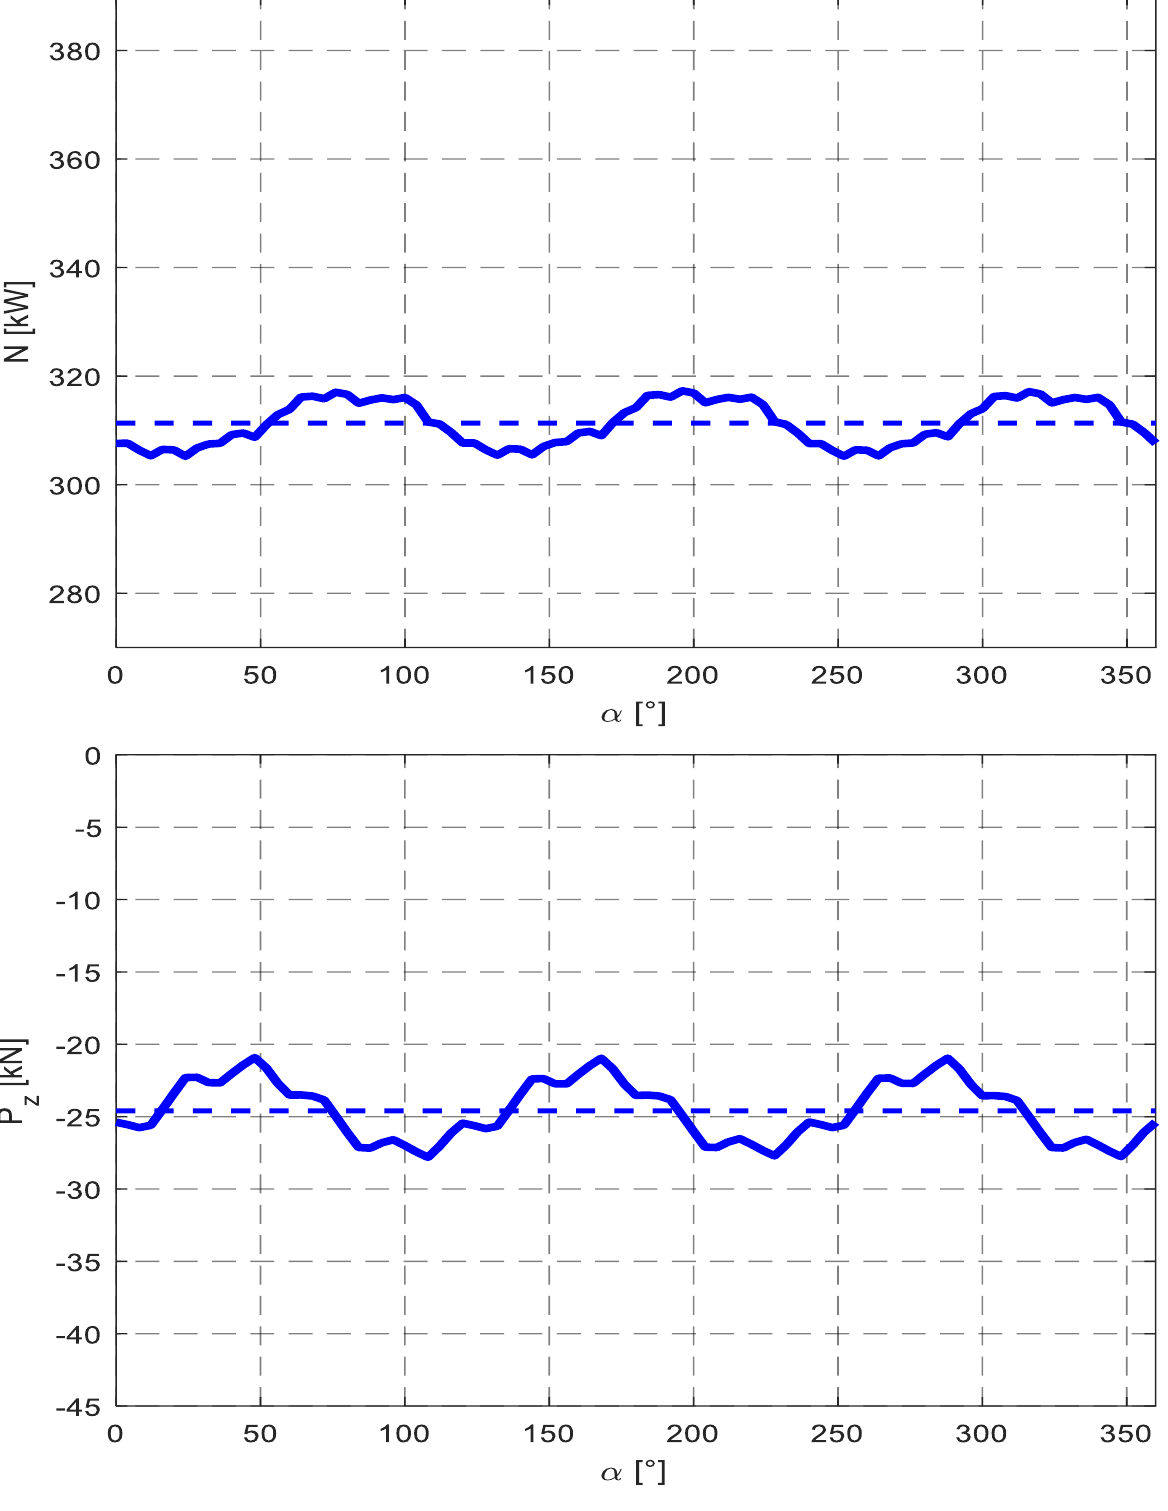
Figure 13. Waveform of the values of power N and cutting head impact force in the direction of shearer’s advance P z for pick arrangement 1a.